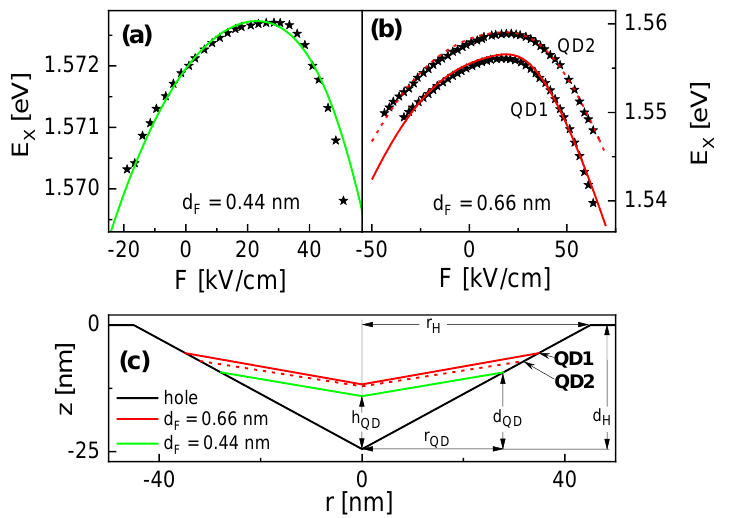
Figure 4. ( a ) Measured exciton energy E X (symbols) of a CSQS with d F = 0.44 nm as a function of F together with results of the effective mass simulation (line); ( b ) measured exciton energy E X (symbols) of two CSQS (QD1, QD2) with d F = 0.66 nm as a function of F together with simulation results (lines); ( c ) proposed cross-sectional shape of a nanohole and of the CSQSs from ( a , b ) determined by a comparison of measured and simulated Stark shift data. In the simulations, the reference position for F = 0 is at z 0 = d H /2. The value of d F denotes the nominal layer thickness of the GaAs material, which is deposited for nanohole